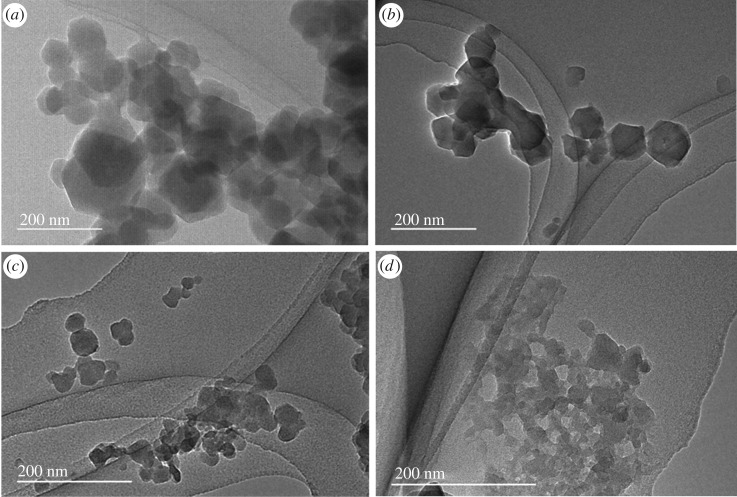
TEM image of (a) ZIF-8, (b) L1@ZIF-8, (c) L1Fc@ZIF-8 and (d) L1Fc2@ZIF-8.